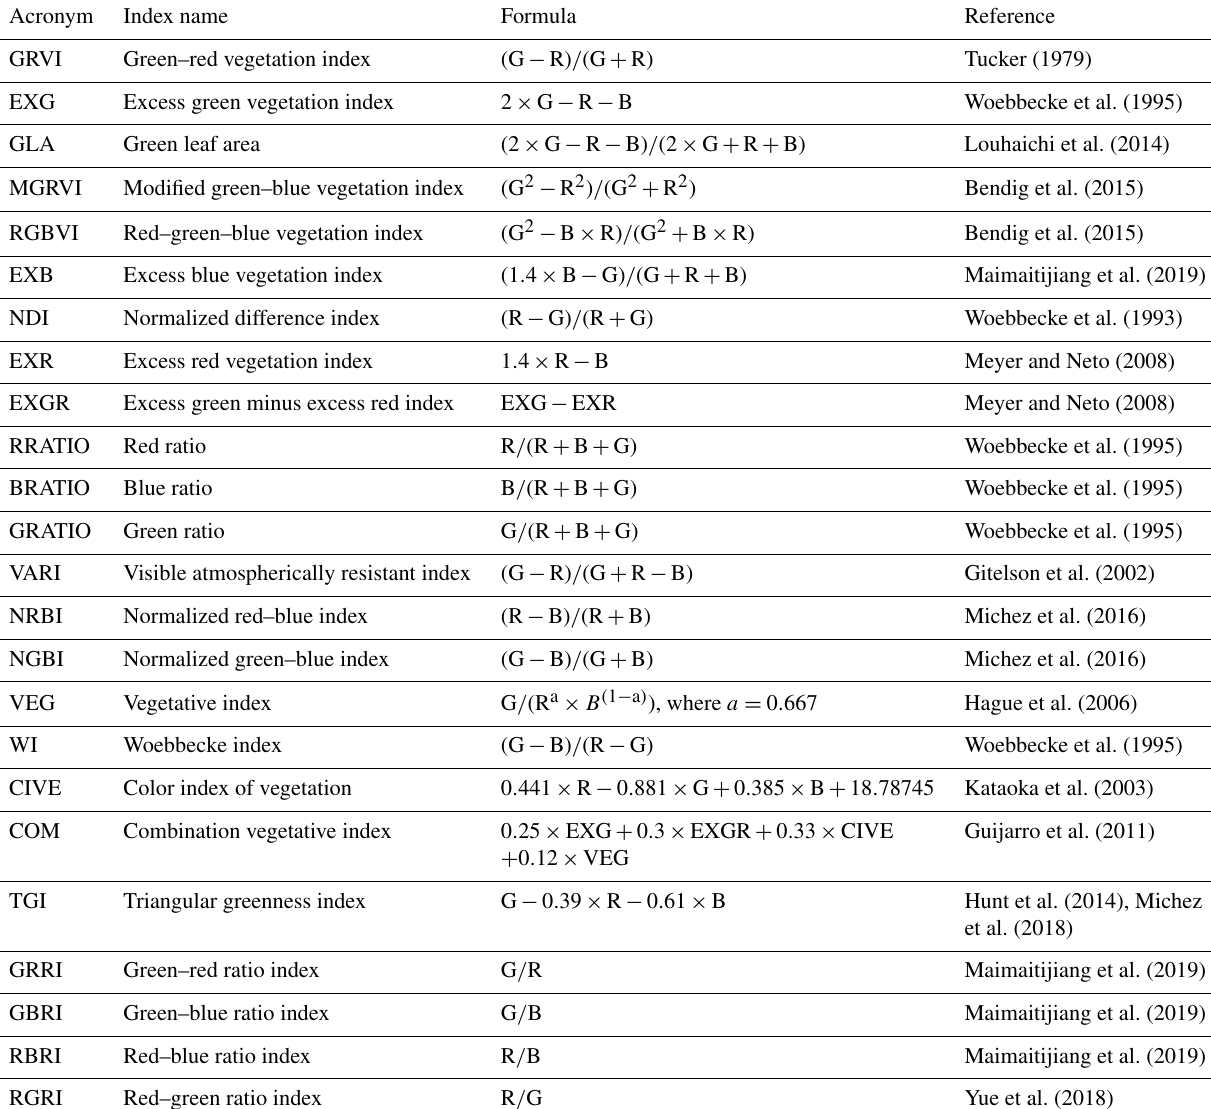
Table A3. Details of the independent variables for quadrat-scale AGB estimation. Note that HSV is for hue, saturation, and